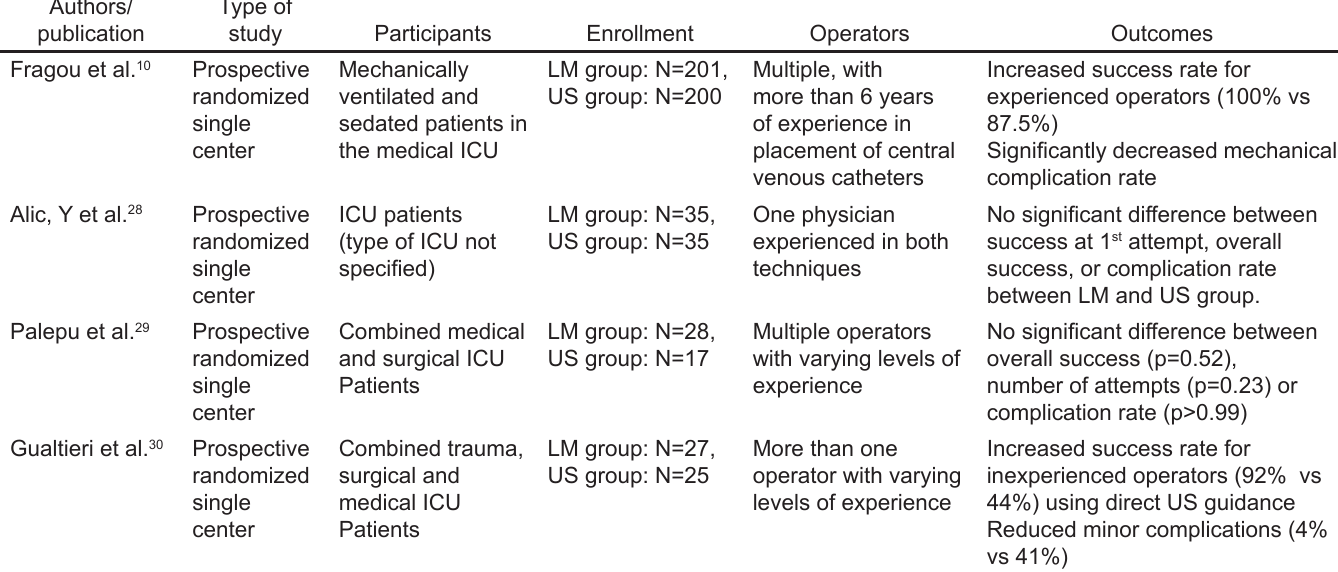
ICU, intensive care unit; LM, landmark; US,